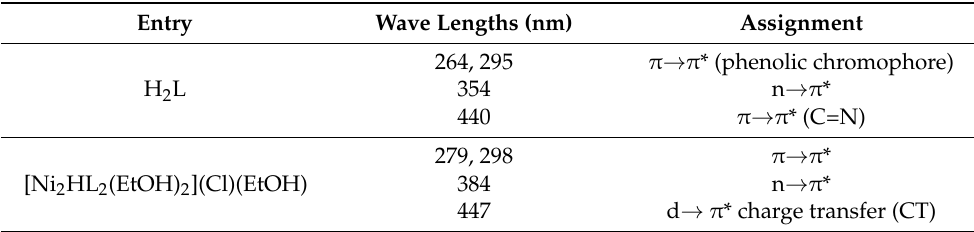
Figure 5. UV/Vis spectra of ligand H 2 L and its nickel complex. Table 1. UV/Vis spectral data for H 2 L and [Ni 2 HL 2 (EtOH) 2 ](Cl)(EtOH).